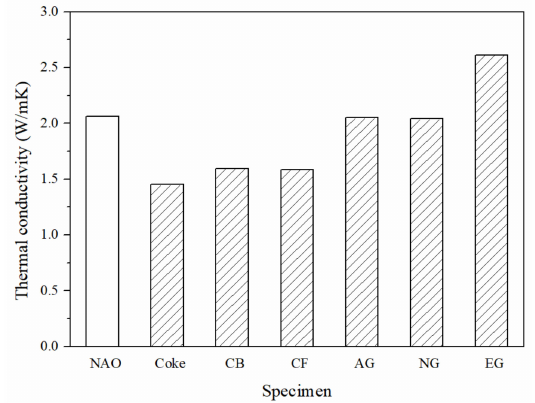
Figure 4. The thermal conductivity of